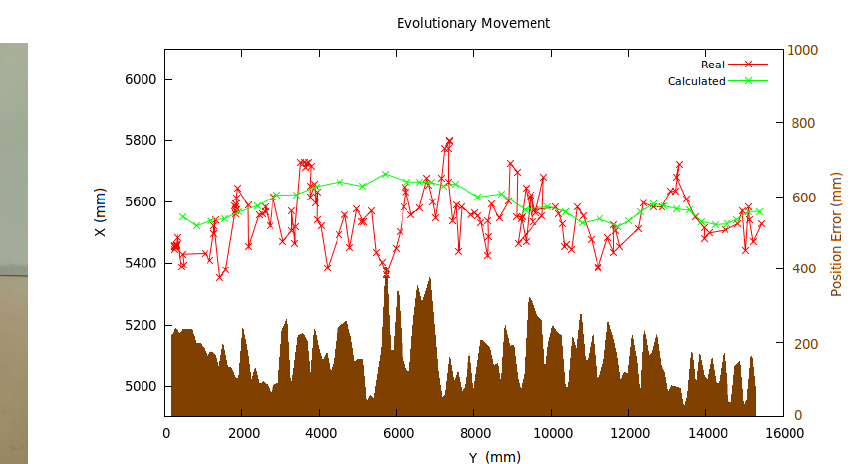
Figure 21. Nao robot traveling a corridor for experiments (left) and estimated localization and position error over time